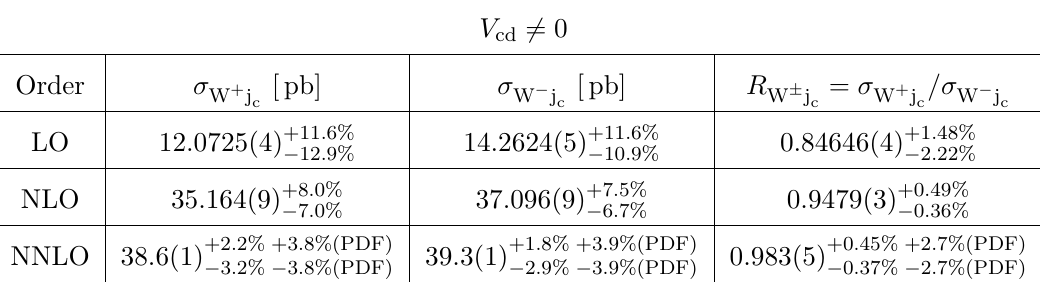
Fiducial cross sections for pp → W + j , pp → W − j , and their ratios at the LHC c c √ at s = 7 TeV at LO, NLO, and NNLO QCD. The digit in parenthesis indicates the Monte Carlo statistical error while the sub- and super-script in per cent indicate the scale variation. In addition, the PDF variation is provided for the NNLO QCD predictions (as indicated explicitly). The contribution due to V = 0 is included at Born level. The NNPDF3.1 sets with α = 0 . 118 cd 6 s are used at orders matching the perturbative